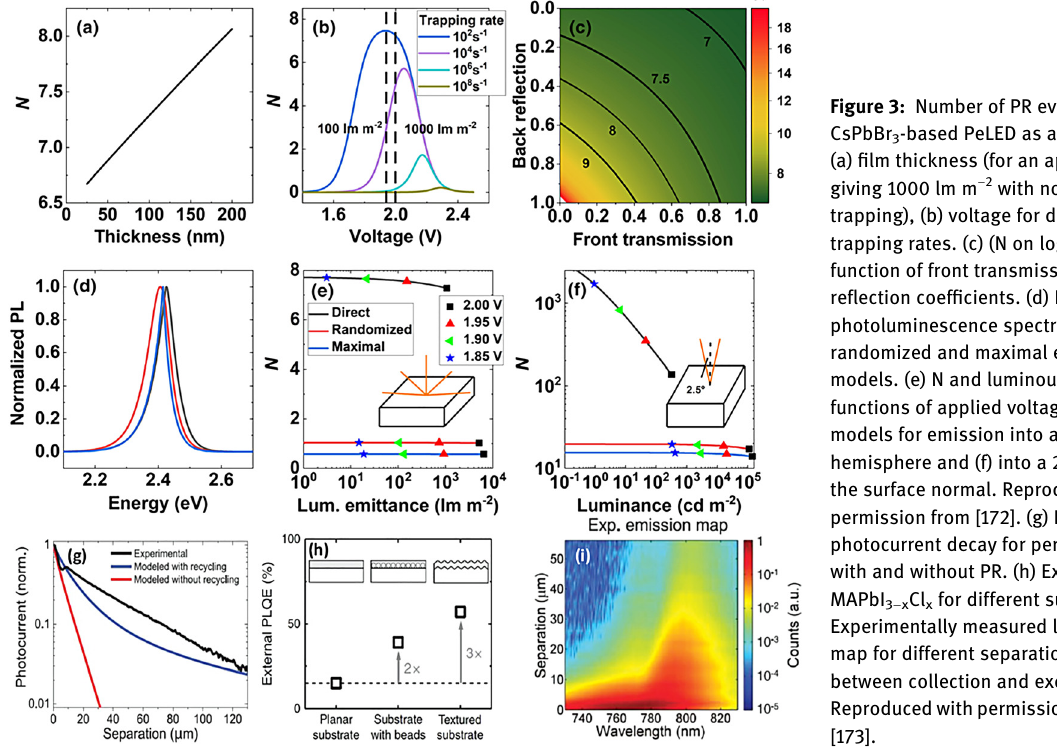
PLQY. By correlating data from transient absorption (TA) and PLQY, the monomolecularnon-radiative recombination has been traditionally attributed to trap-mediated SRH pathways whereas the radiative bimolecular recombination was shown to originate from band-to-band transitions [176].